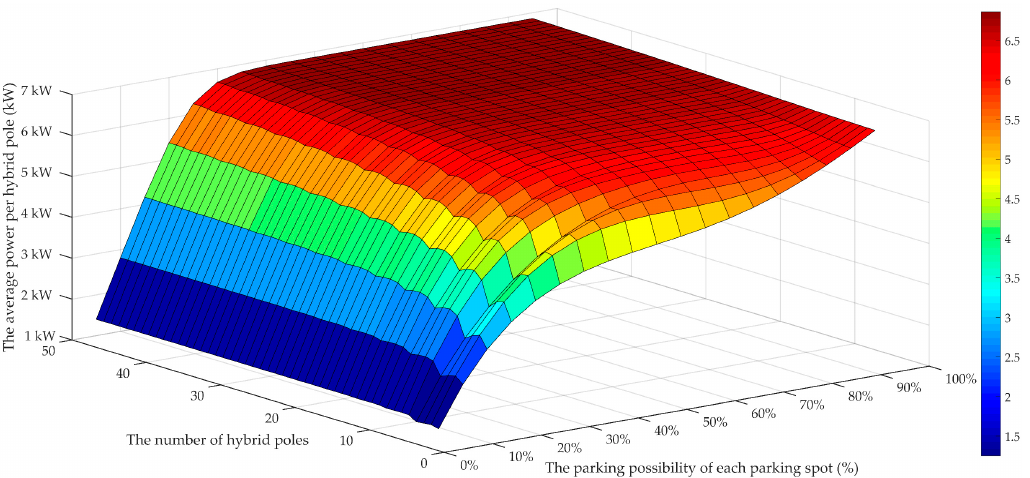
Figure 10. The functional image of average power per hybrid pole under binomial distribution. The efficiency promotion α of hybrid poles relative to traditional poles is in following formula, as shown in Figure 11.